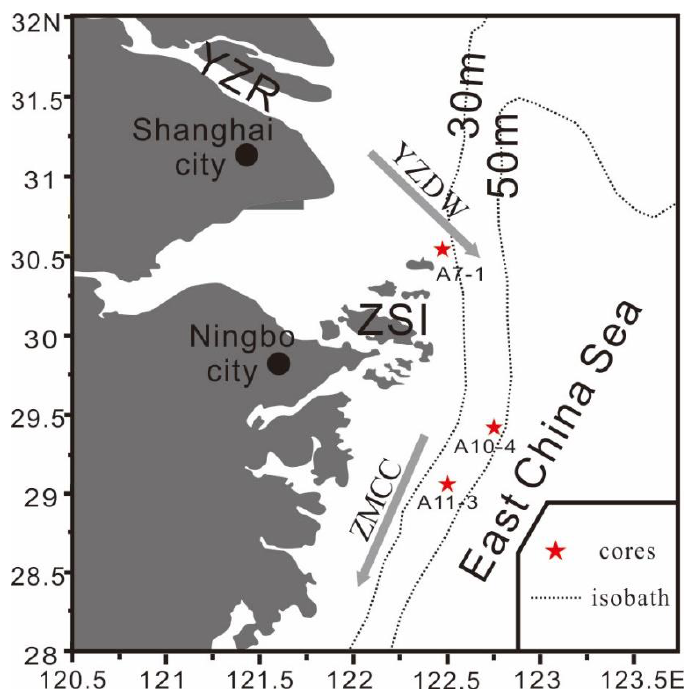
Figure 1. Study area and location of sampling (core samples) sites (YZR–Yangtze River, ZSI–Zhoushan Islands, YZDW–Yangtze Diluted Water, ZMCC–Zhe Min Coastal